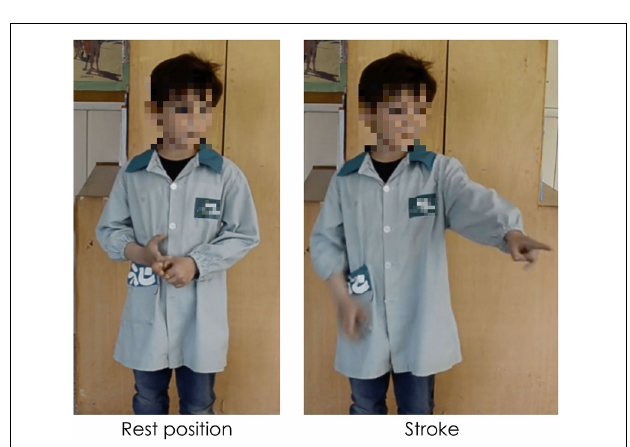
FIGURE 2 | Caption of a deictic gesture while saying “aquell RATOLÍ” (“that MOUSE”). Capitalization indicates the word accompanied by a gesture.